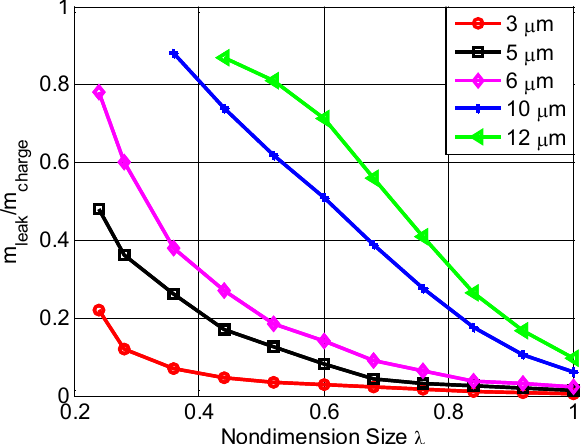
Figure 9. The mass leakage effect on the size factor for different seal gap heights.